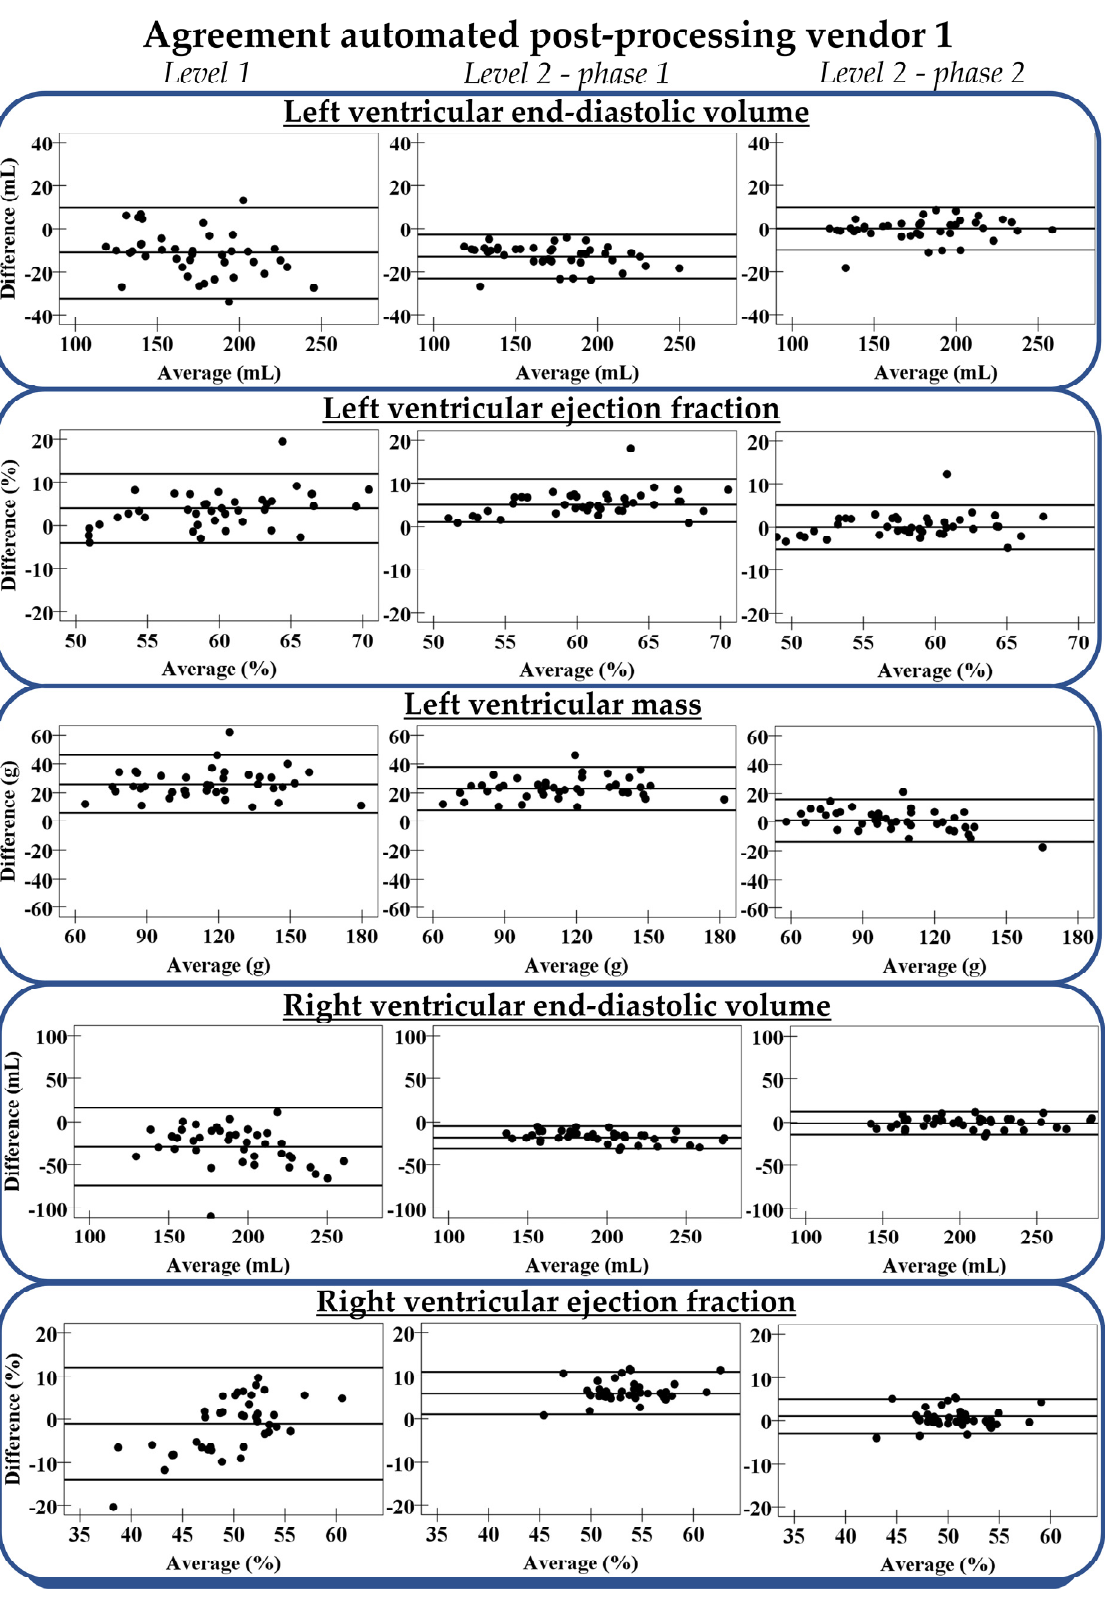
Figure 5. Agreement between different Levels of automated post-processing in vendor 1 and gold standard manual contour-tracing. From left to right: Level 1, Level 2 before correction of the relative-to-manual standard error (phase 1), and Level 2 after correction (phase 2). The three lines represent mean difference with limits of agreement.